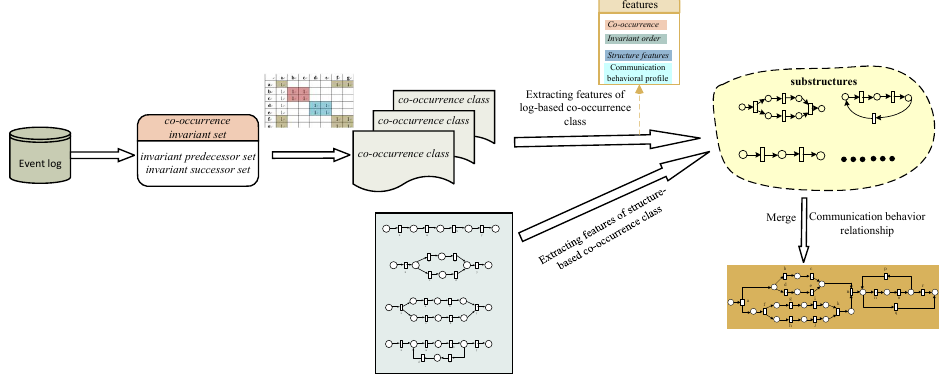
Figure 5. Framework of the proposed